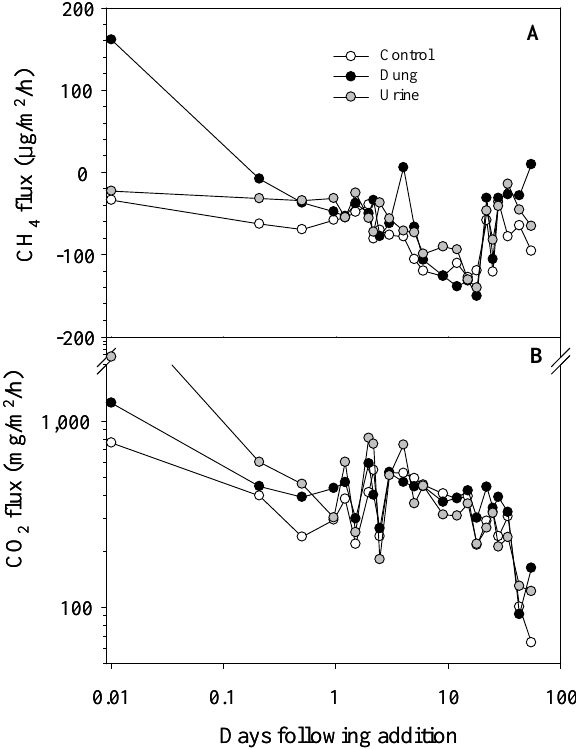
Figure 2. Mean CH 4 and CO 2 flux from urine, dung, and control plots (n = 3). The negative values of CH 4 flux express uptake by